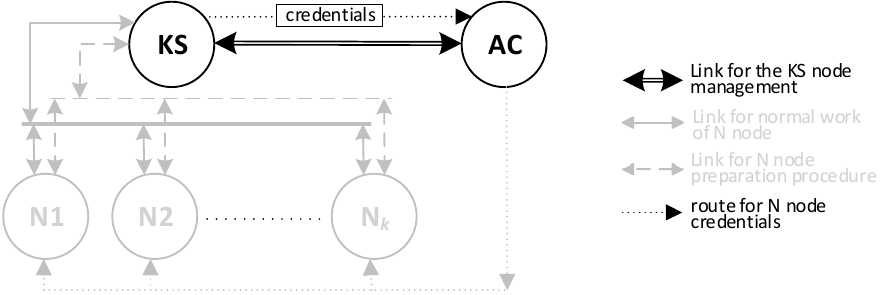
Figure 8. The way the AC node and the KS node work together during the procedure for preparing the credentials for the given N node.